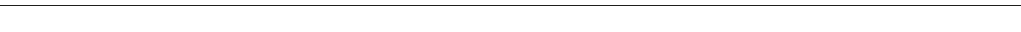
Fig. 1 Genotyping platform performance and quality control. a Coverage plot of the MAPT gene on the ACE platform highlighting the augmented coverage over and above that seen within the SureSelect alone (yellow — regions covered by custom augmented probes, brown regions — covered by ACE probes without augmentation). b Sensitivity and speci fi city of 5 combinations of variant callers at different VAF of HapMap control mixes. DNA from cell-line NA12878 was spiked into DNA from cell-line NA12877 using 2, 5, 10, 20, or 50 ng of NA12878, making up to 1 µ g total DNA with NA12877 to create relative VAF of 0.2% – 5%. deepSNV, MuTect2, Varscan2 somatic caller and Varscan un-paired calling were employed in different combinations to determine the sensitivity and speci fi city to detect variants at each VAF. The optimum caller pipeline was set at a VAF of 0.5% using a dual calling approach for variants called by either MuTect2 or Varscan2, which had a 92.98% sensitivity and 99.9984% speci fi city. c Number of observed variants called by either MuTect2 or Varscan2 at each VAF in biological replicates highlighting consistent performance of the sequencing pipeline. d Proportion of known variants present in the mixed HapMap controls that were detected using our primary calling pipeline. VAF > 1% were consistently detected when the sequencing depth was >1000-fold, but VAF > 0.5% required >4000-fold depth to minimise the false-negative rate of any caller across the 102 gene 285 kb panel. e Schematic overview of the calling algorithm used in the study. Variants called from paired sample calling by either MuTect2 or Varscan2 were selected. All brain regions from those individuals were then compared to both each other (for intra-regional variation), and then to all other individuals (for inter individual variation) for those alleles to ensure that detected variants from Varscan2 or MuTect2 were truly focal or Multi-focal in nature. f The average depth per base for each sequencing platform: ACE (pink) or Haloplex HS (blue). The mean sequencing depth across the whole panel per sample is shown in the inset violin plot for both platforms again using the same colour